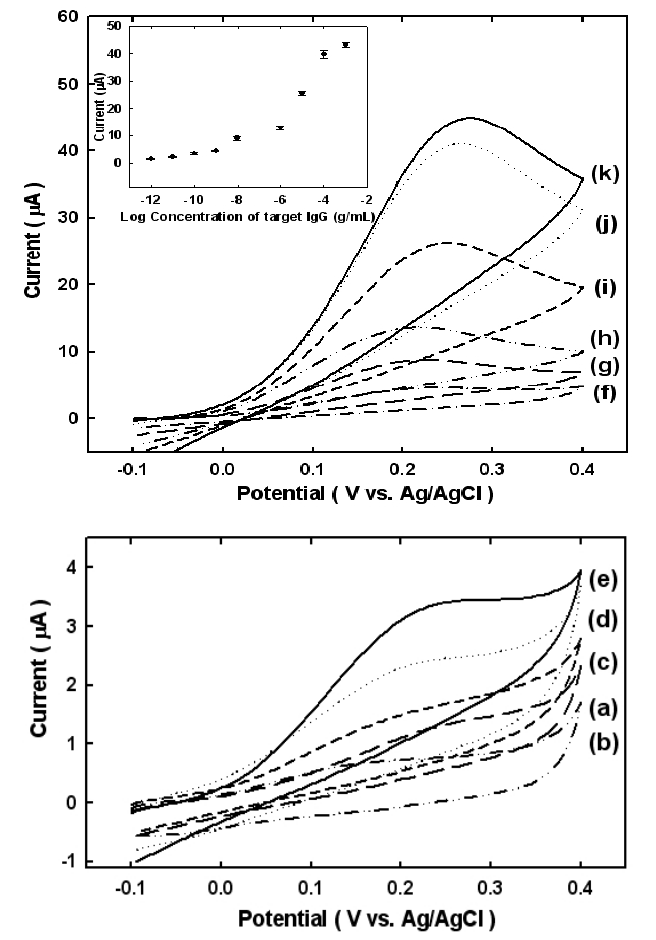
Figure 3. CV of a sandwich-type electrochemical immunosensor for mouse IgG at various concentrations of mouse IgG and goat IgG as negative control : (a) 100 μ g mL –1 goat IgG, (b) 0 g mL − 1 , (c) 1 pg mL –1 , (d)10 pg mL − 1 , (e) 100 pg mL − 1 , (f) 1 ng mL –1 , (g) 100 ng mL − 1 , (h) 1 μ g mL –1 , (i) 10 μ g mL − 1 , (j) 100 μ g mL –1 , and (k) 1 mg mL − 1 mouse IgG. All CV were obtained after incubating for 1min in EB containing 1 mM APP and at a scan rate of 20 mV s –1 (In box, calibration plot obtained from the currents at 0.2